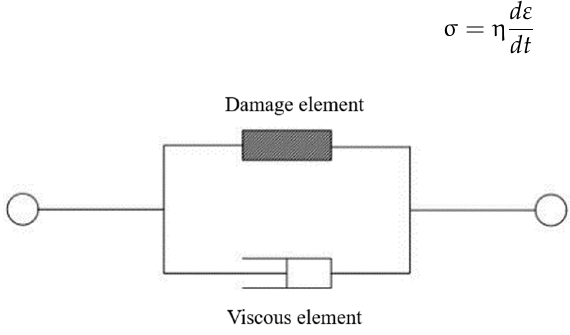
Figure 12. Differential element model.